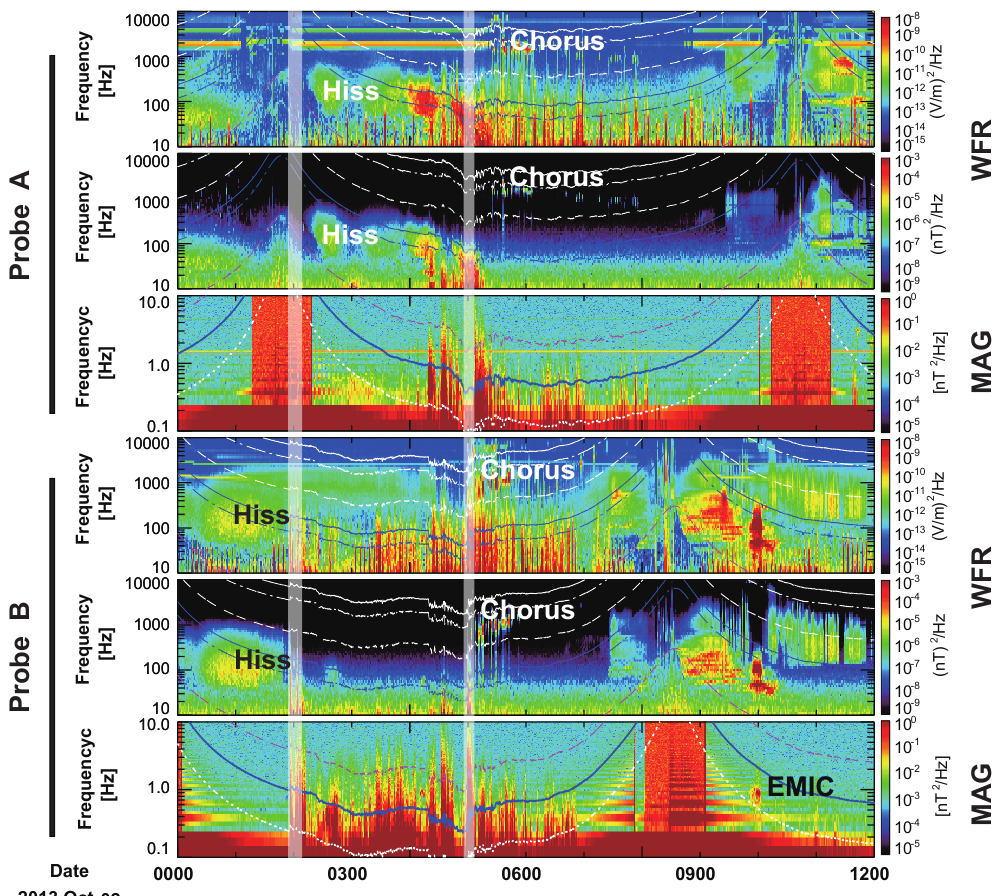
Figure 10. Corresponding to the radiation belt electron flux measurements, Van Allen Probes EMFISIS Wide-Frequency Receiver (WFR) observations of electric and magnetic field spectral intensity at 10Hz–10kHz and Fluxgate Magnetometer (MAG) observations of electric field spectral intensity at 0.1–10Hz. The overplotted curves in the WFR spectrograms, from top to bottom, denotes the electron f ce , 0 . 5 f ce , 0 . 1 f ce , f LHR , 0 . 5 f LHR , and f cp , respectively, where f ce , f LHR and f cp represent equatorial electron cyclotron frequency, lower hybrid resonance (LHR) frequency, and proton cyclotron frequency. The overplotted curves in the MAG spectrograms denote the local H + , He + and O + ion gyrofrequencies, respectively. The two vertical lines represent the start of the two intense P dyn enhancements, and a number of activities of chorus, hiss, and EMIC waves are